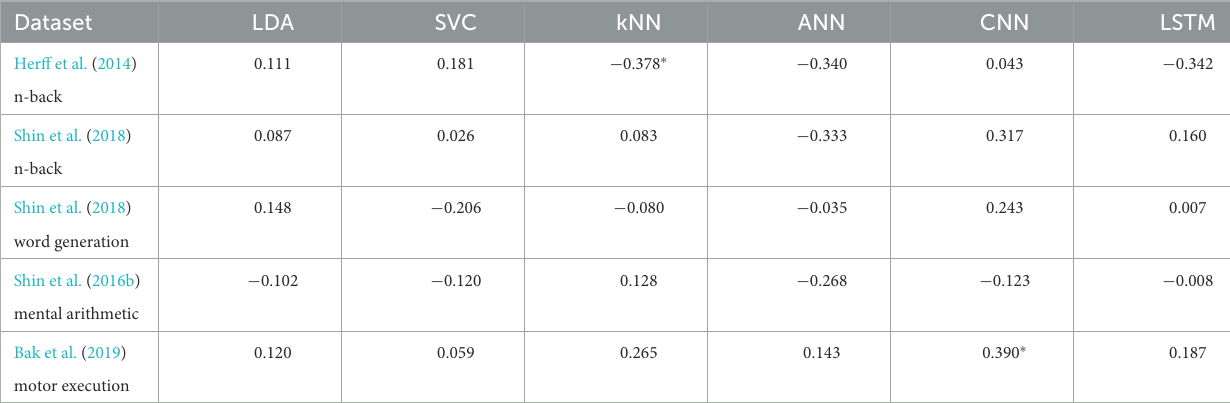
TABLE 3 Correlation coefficients of the relationship between accuracy and number of training